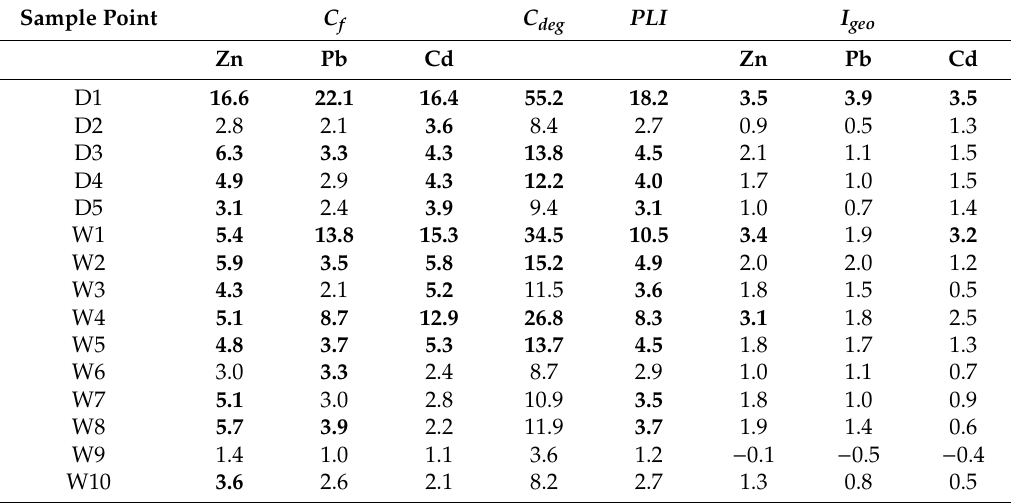
Table 7. Assessment of HM pollution indices in studied topsoil in relation to the median for topsoil in S Poland as a background value [59].